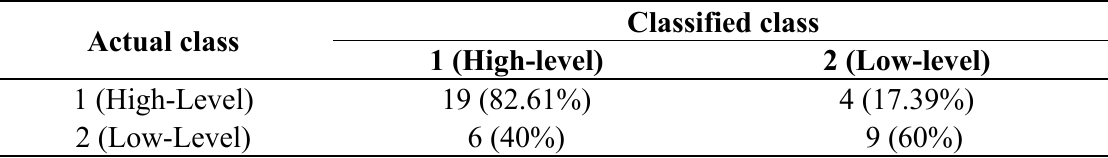
Table 13. RST-NB model (model X) results with only significant